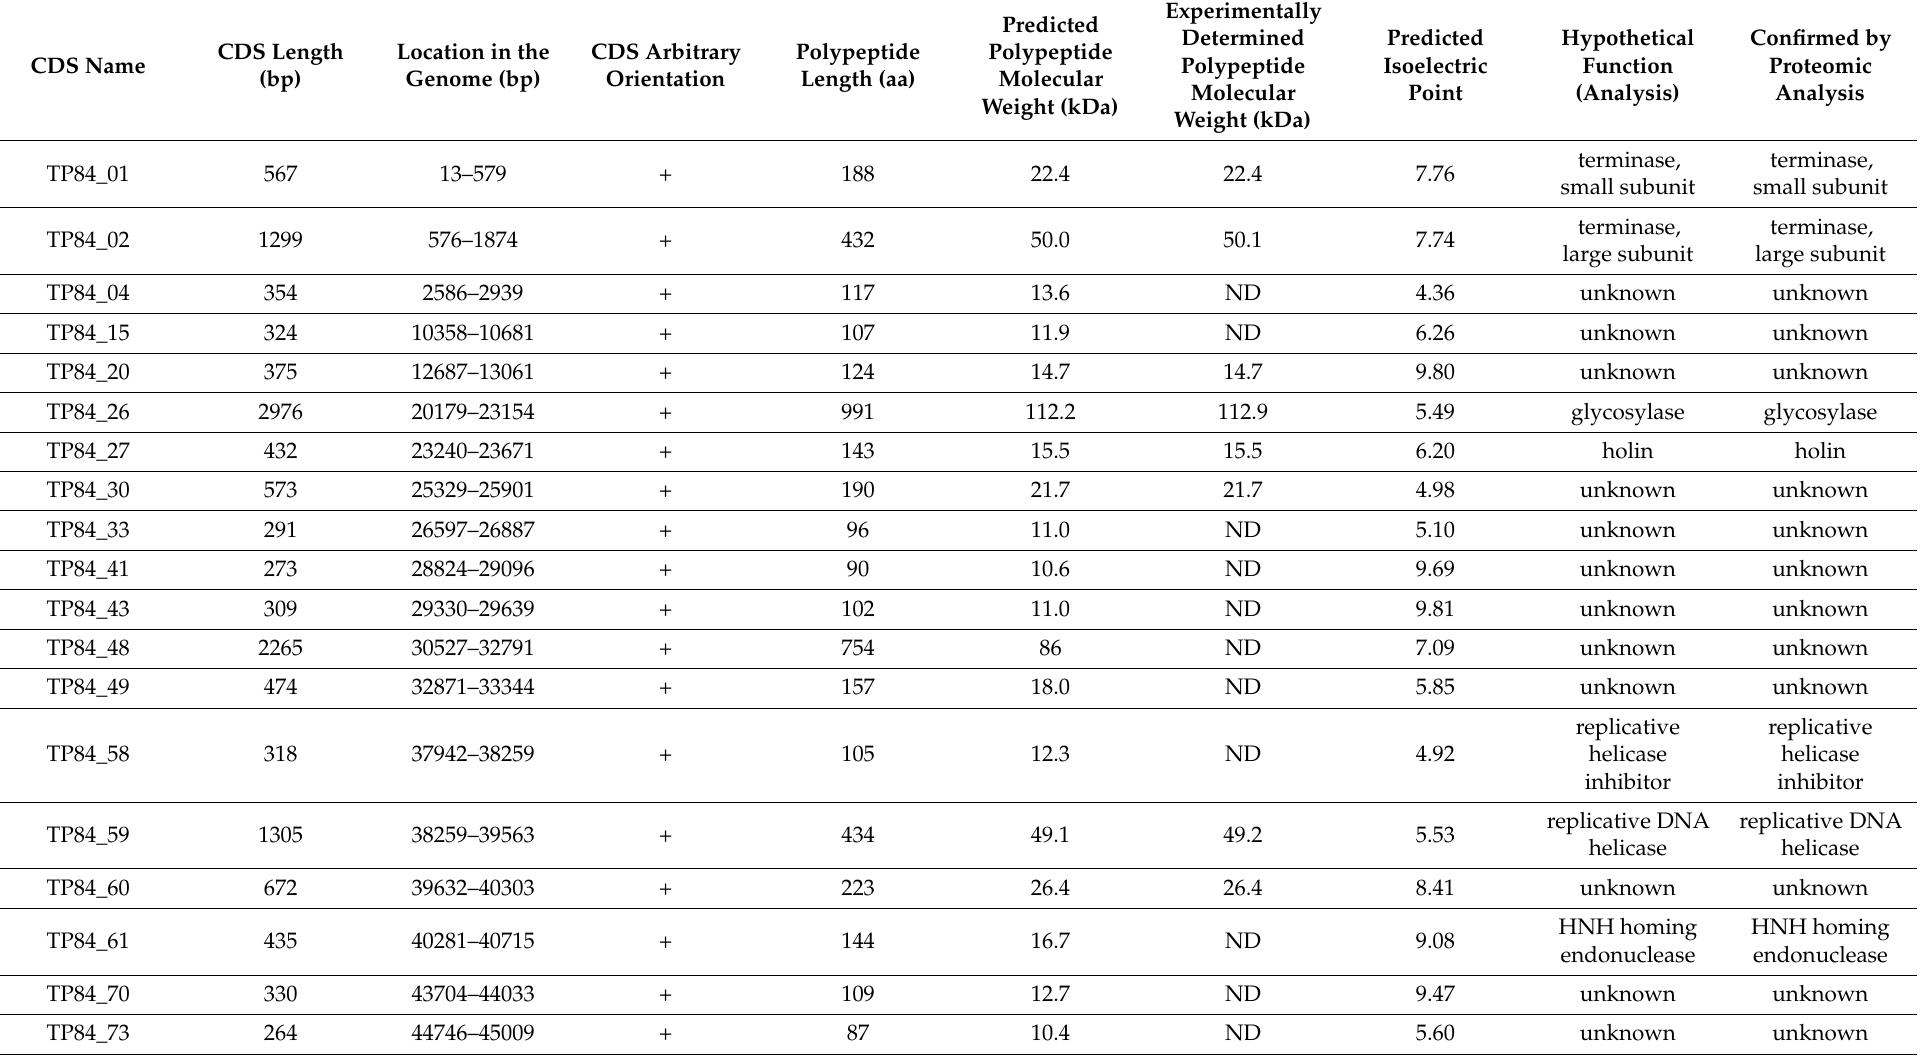
Table 1. New (this work) experimentally confirmed functional CDSs of bacteriophage TP-84 genome—an update